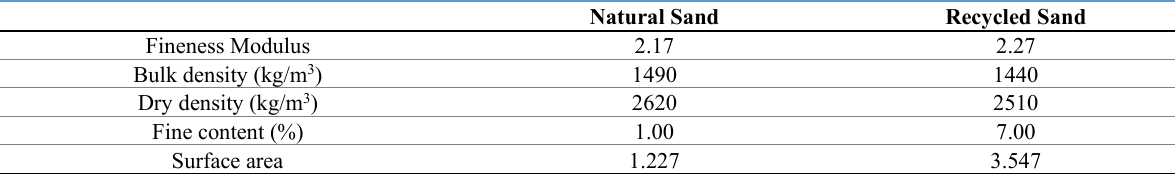
Table 4. Fine aggregates characteristics.